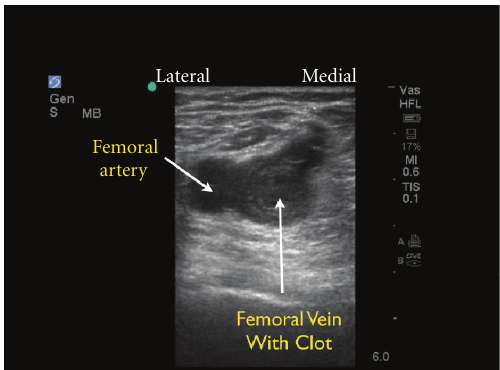
Figure 28: Deep venous thrombosis of the femoral vein, short axis